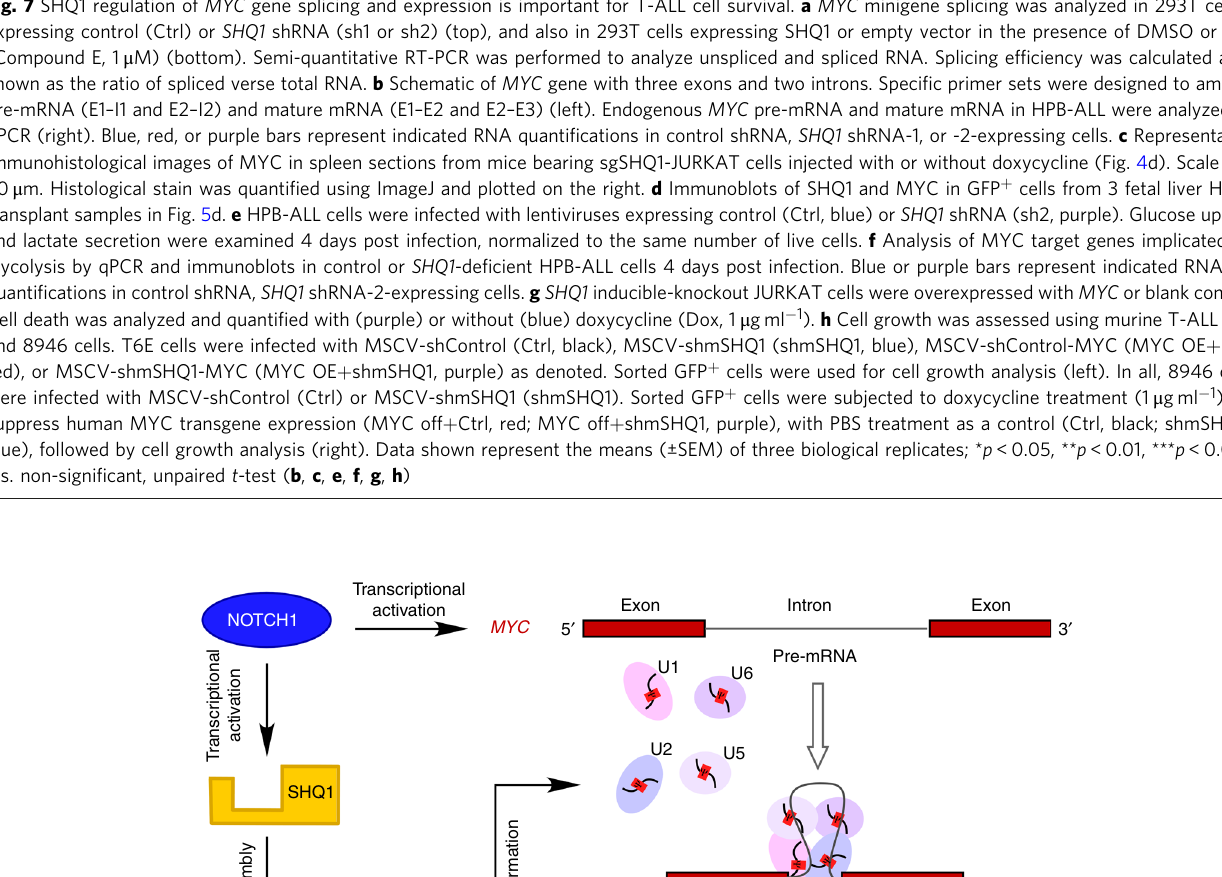
Fig. 7 SHQ1 regulation of MYC gene splicing and expression is important for T-ALL cell survival. a MYC minigene splicing was analyzed in 293T cells